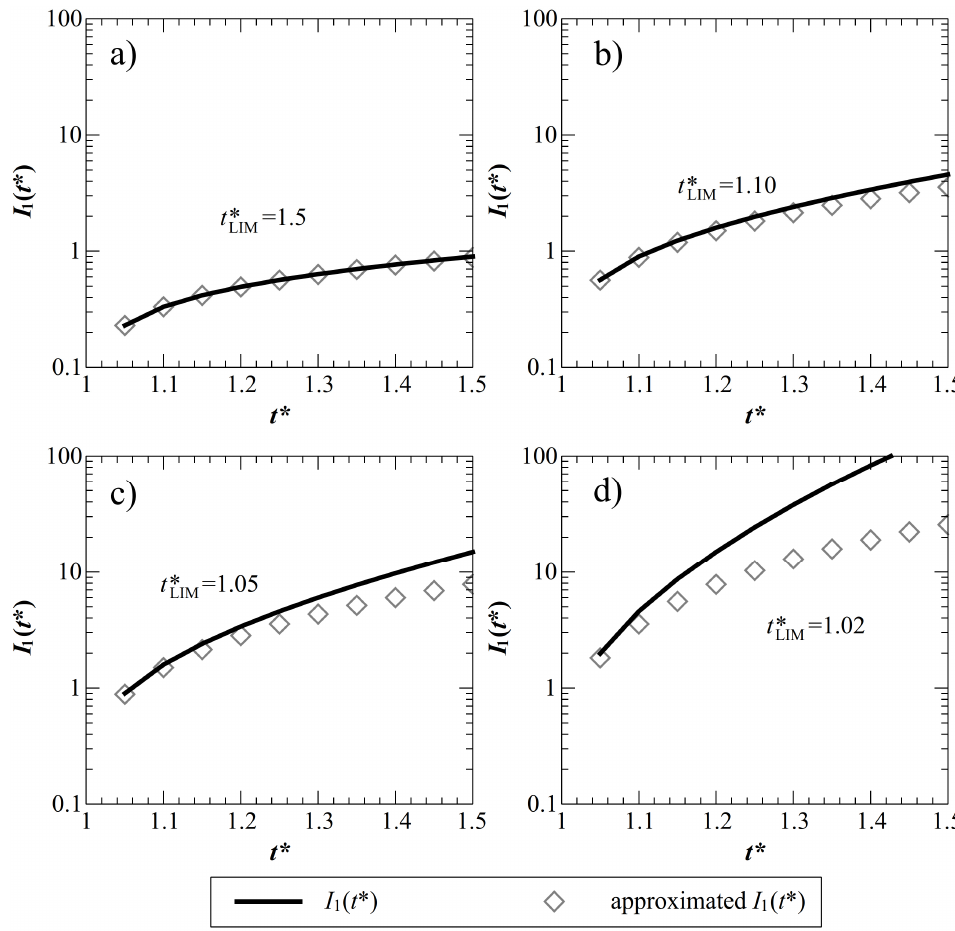
Figure 1. Comparison between the modified Bessel function 𝐼 (cid:2869) and its approximation (Equation for four different values of t ∗ (22)) for four different values of 𝑡 (cid:3013)(cid:3010)(cid:3014)∗ : ( a ) 𝑡 (cid:3013)(cid:3010)(cid:3014)∗ (cid:3404) 1.5 , ( b ) 𝑡 (cid:3013)(cid:3010)(cid:3014)∗ (cid:3404) 1.10 , ( c ) 𝑡 (cid:3013)(cid:3010)(cid:3014)∗ (cid:3404) 1.05 , ( d ) 𝑡 (cid:3013)(cid:3010)(cid:3014)∗ (cid:3404) 1.02 .